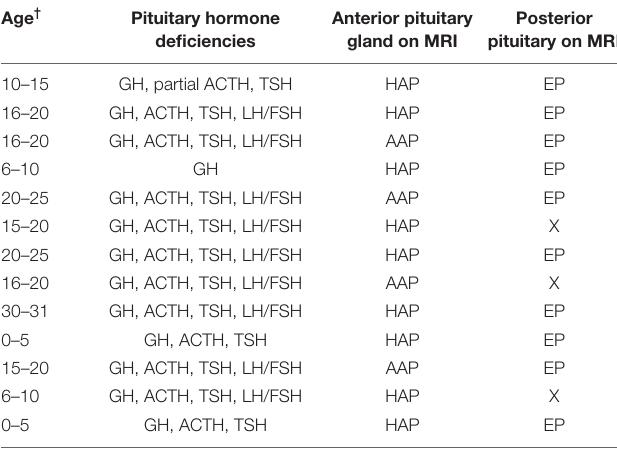
TABLE 1 | Characteristics of subjects with congenital hypopituitarism.